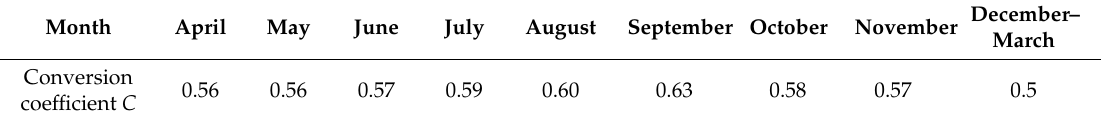
Table 2. The conversion coefficient C between Φ 20 cm and E601 in different months.